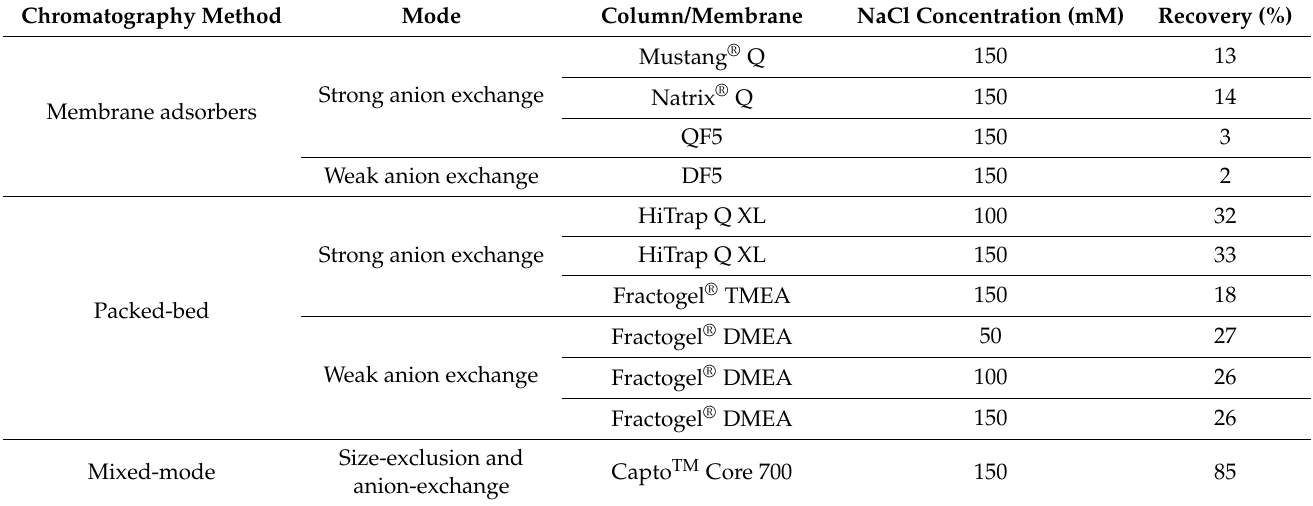
Table 1. Summary of rVSV-S recovery following purification using membrane adsorbers and packed-bed chromatography. Chromatography